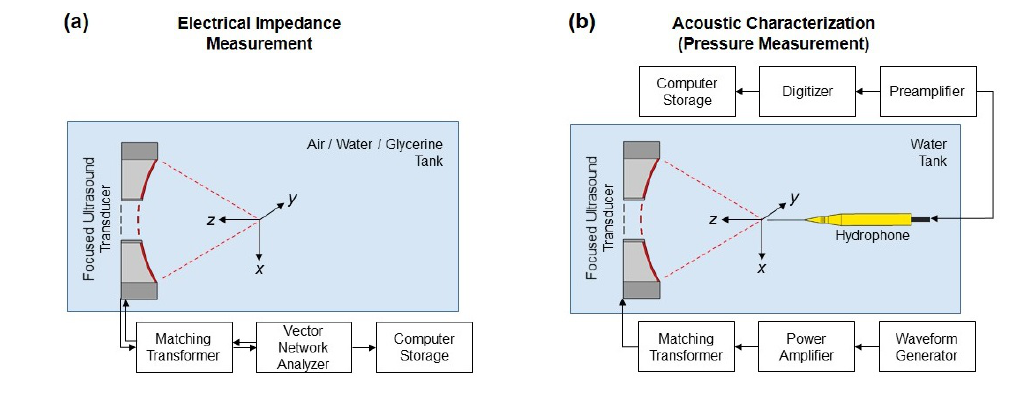
Figure 3. Schematic of the ( a ) electrical impedance measurements (Section 3.2) and of the ( b ) acoustic characterization (pressure measurements from which acoustic power was calculated; see Section